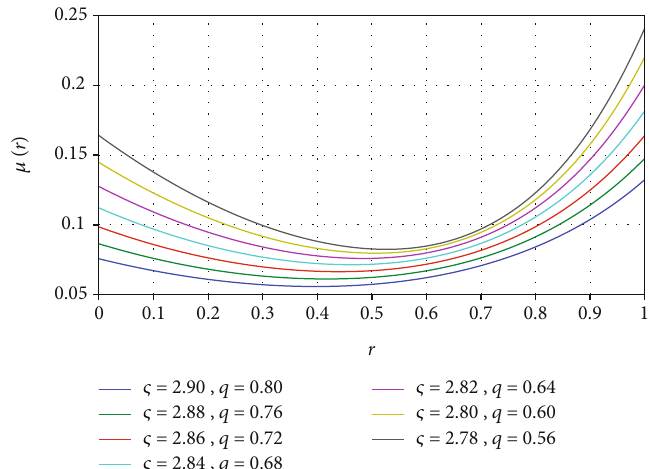
Figure 1: The exact solution μ ð r Þ of (120) for r ∈ ½ 0, 1 (cid:2)